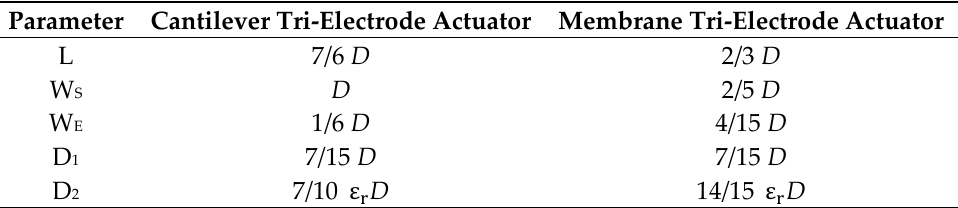
Figure 3. ( a ) Simulation structure of the cantilever actuator; ( b ) Structure of the square membrane actuator . Table 1. Structure Parameters Used in Displacement